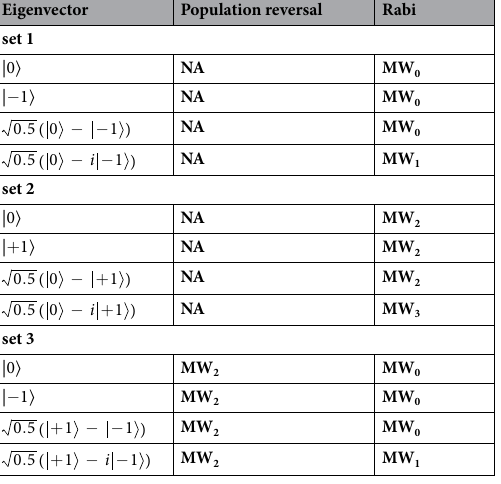
Table 1. Eigenvectors for state tomography. NA, not available. A MW 2 π pulse is used to carry out population reversal when eigenvector set 3 is used. Rabi oscillation scheme is then executed by MW channel listed in collum “Rabi”.